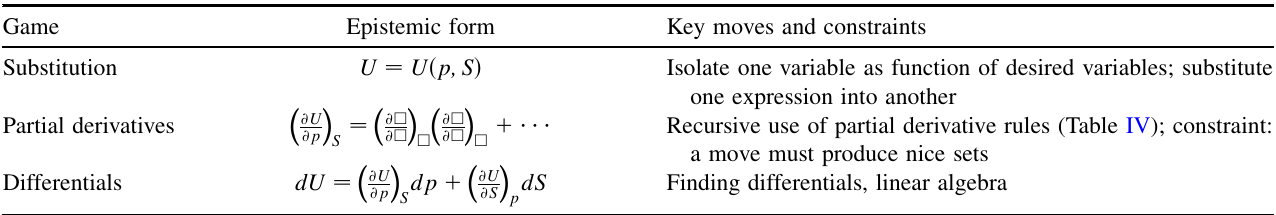
TABLE III. Summary of target epistemic forms and key moves for each epistemic game. Game Epistemic form Key moves and constraints Substitution Partial derivatives Finding differentials, linear